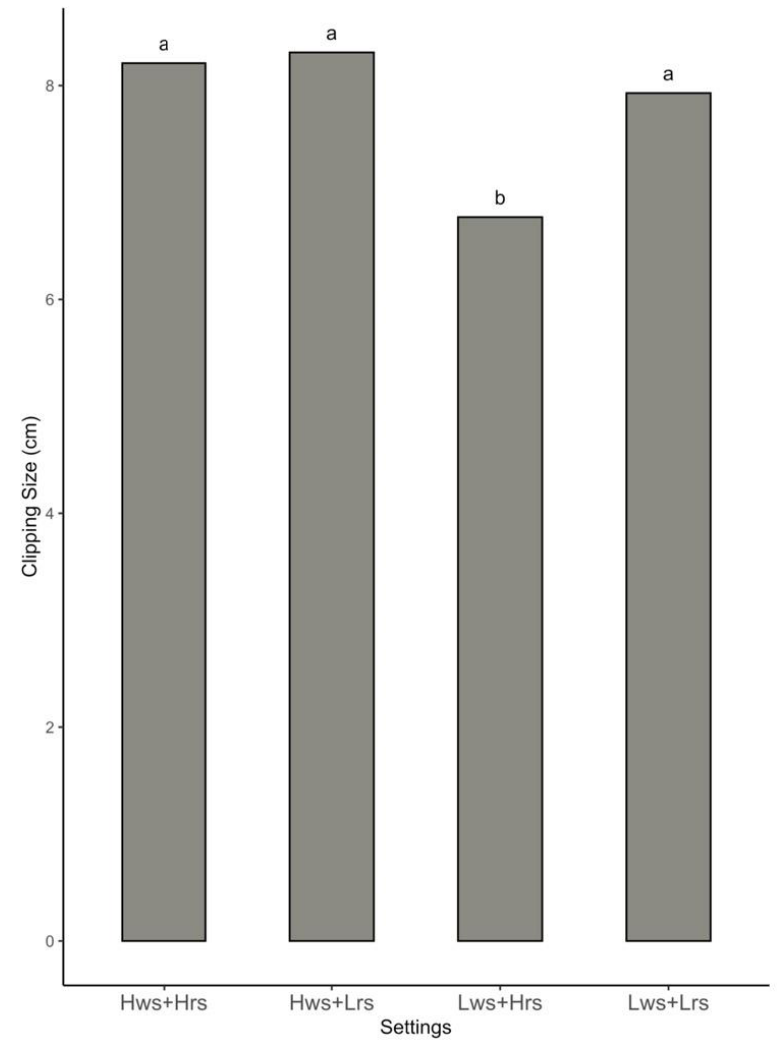
Figure 7. Effect of setting configuration on clippings size. Means denoted by different letters are significantly different at p < 0.05 (LSD test). Hws—High working speed; Lws—low working speed; Hrs—high rotation speed; Lrs—low rotation speed. 3.2. Second Trial: Performance of the Two Mower Versions in the Alley Cropping Farming System Leaf wetness sensors measured an average leaf wetness of 6.35 during the mowing treatment carried out from 9:30 a.m. to 10:20 a.m. on 11 February 2022, thus evidencing the presence of dew on the leaves’ surface. Sensors detected an average leaf wetness of 0 during the mowing treatment performed from 12:00 p.m. to 12:50 p.m. on the same day, pointing to the absence of dew. Figure 8 reports the trend of the average leaf wetness on the day of the mowing treatments measured by